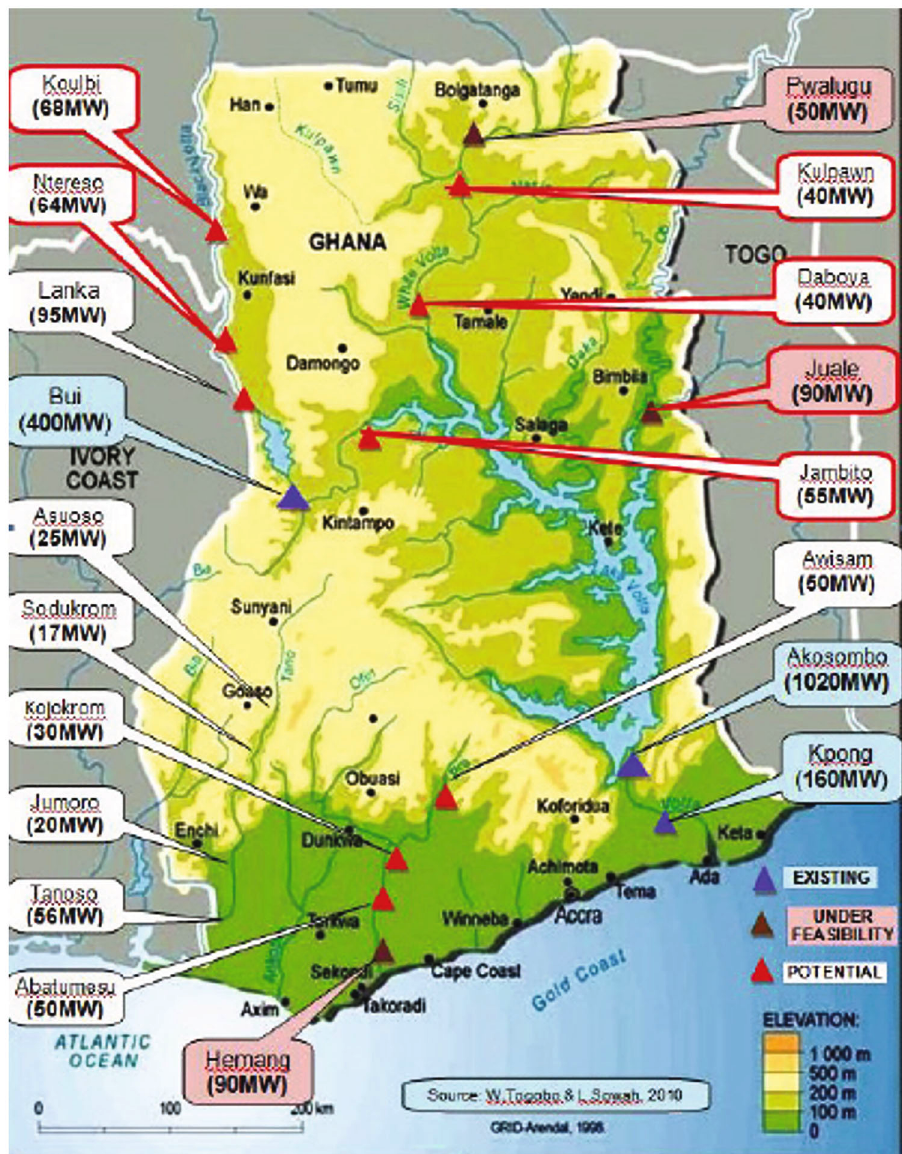
Figure 2: Existing and potential hydropower sites in Ghana